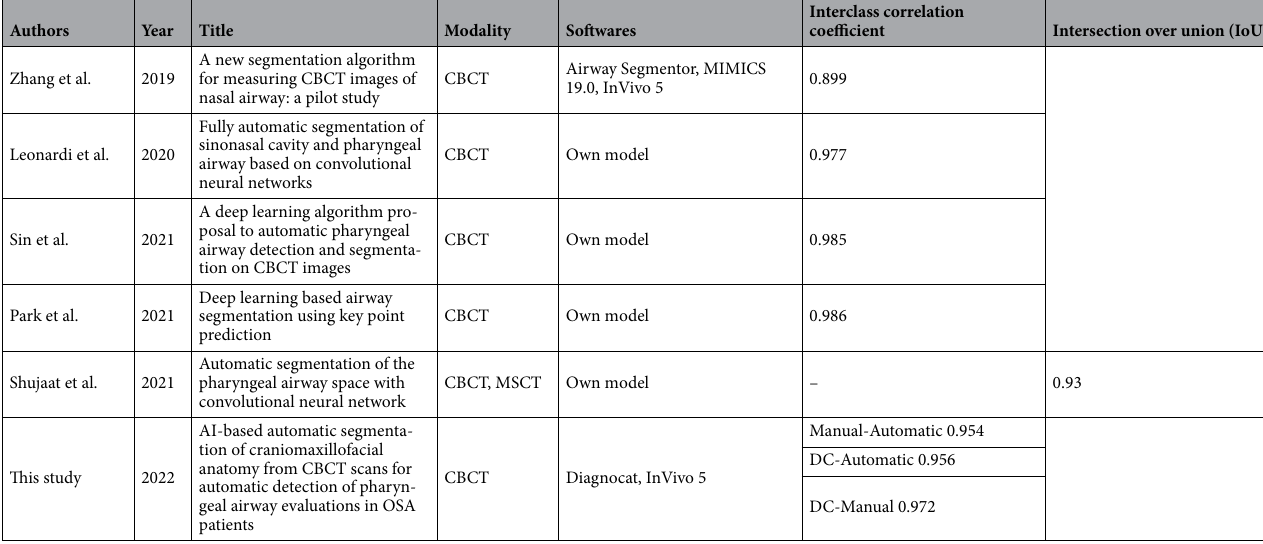
Table 4. Comparative table of the studies using deep learning algorithms for pharyngeal airway volume segmentation and